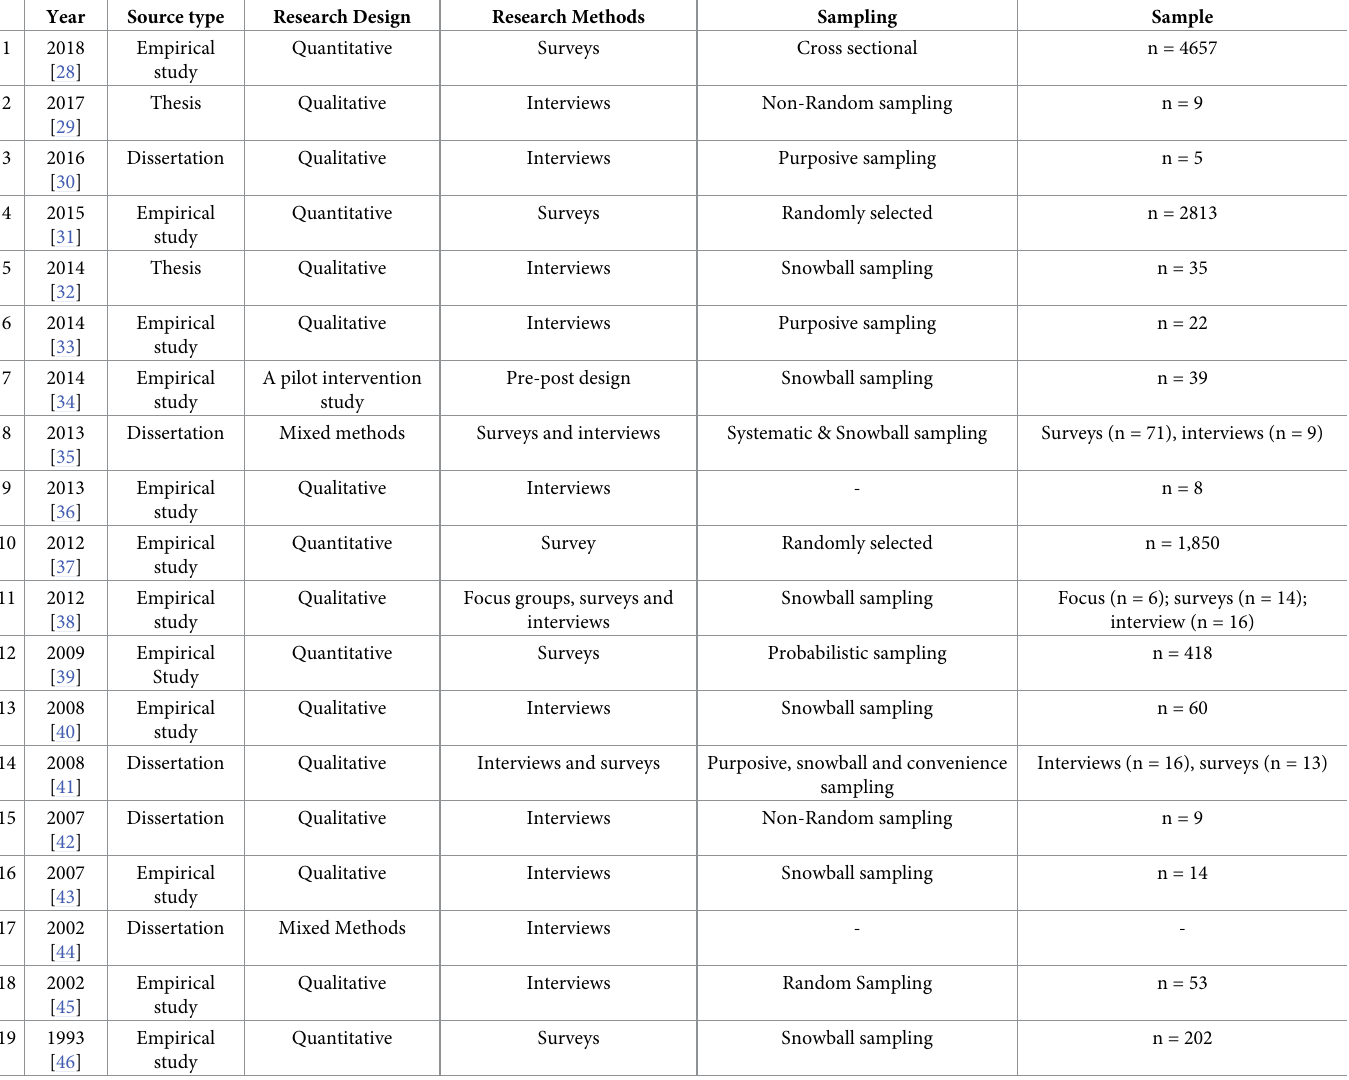
Table 2. Study key characteristics. Edmonton, AB, Canada,